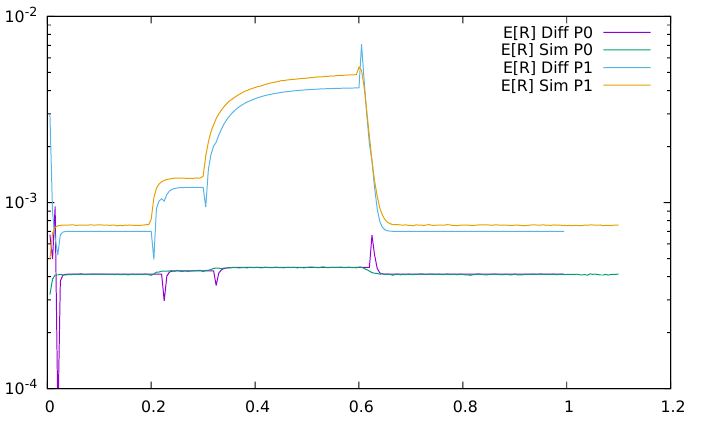
Figure 25. Mean response time at the switch as a function of time, (cid:101) = 0.2, diffusion, and simulation results.